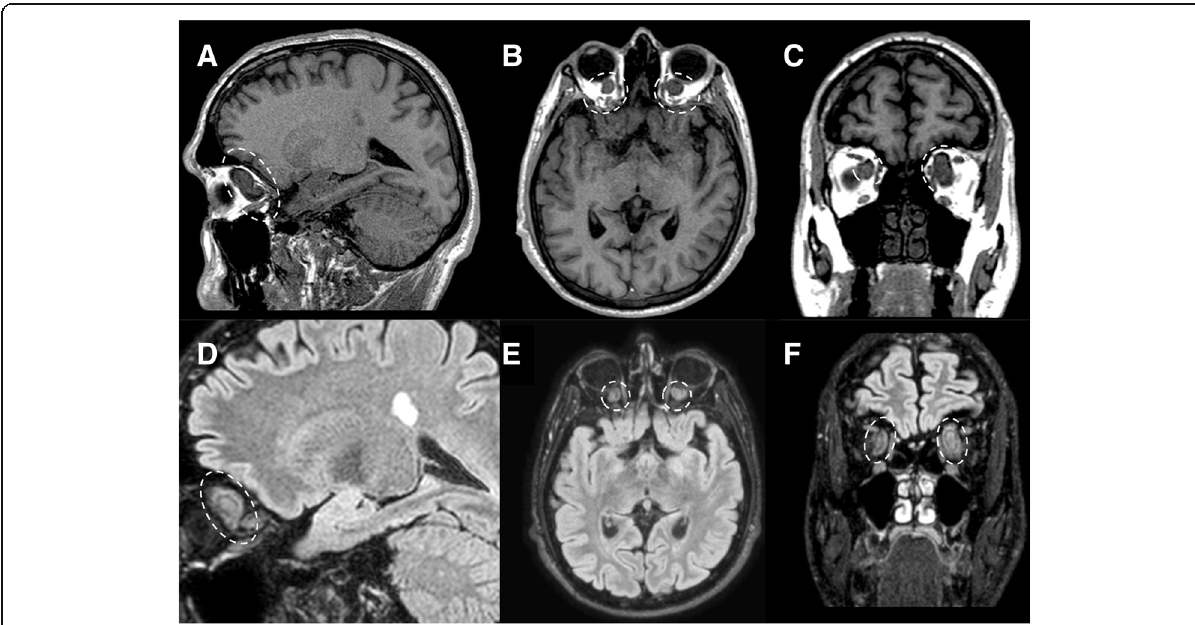
Fig. 18 Optic nerve gliomas. MRI T1-weighted sagittal ( a ), axial ( b ), and coronal ( c ) images show bilateral intraorbital hypointense masses (dotted circles) centered on the optic nerve. FLAIR images ( d – f ) well depict the isointense masses causing enlargement of the optic nerves (dotted circles)